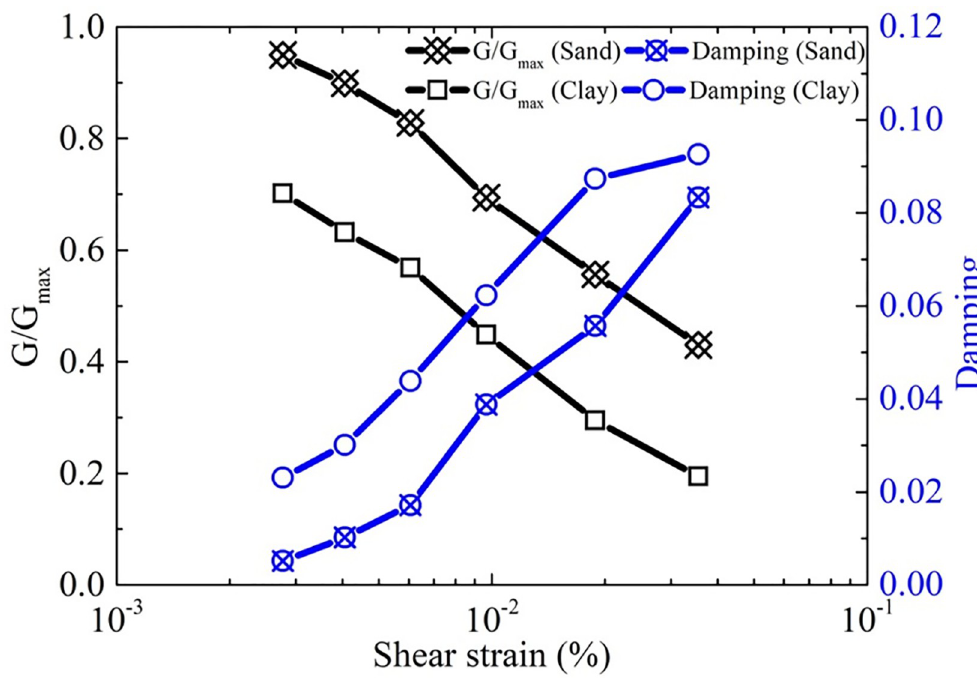
Fig 4. Dynamic parameters of sand and